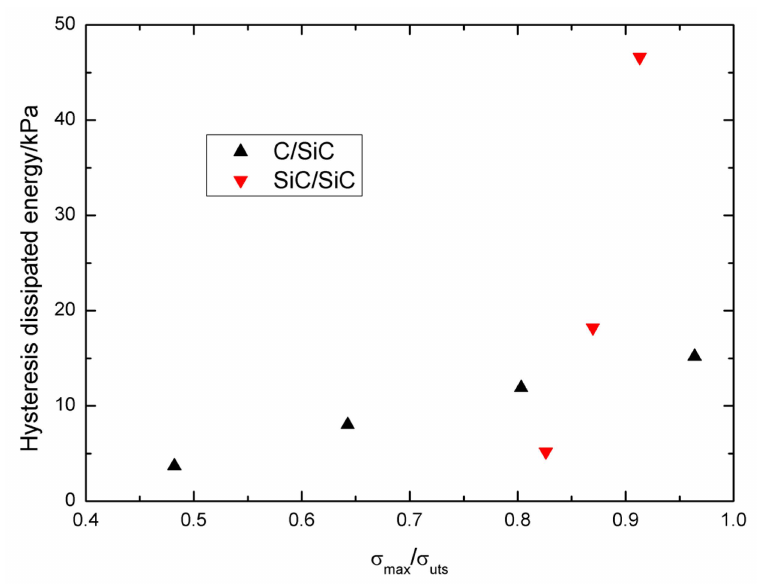
Figure 12. The hysteresis dissipated energy vs. normalized stress σ max / σ uts curves of cross-ply C/SiC and SiC/SiC composites.